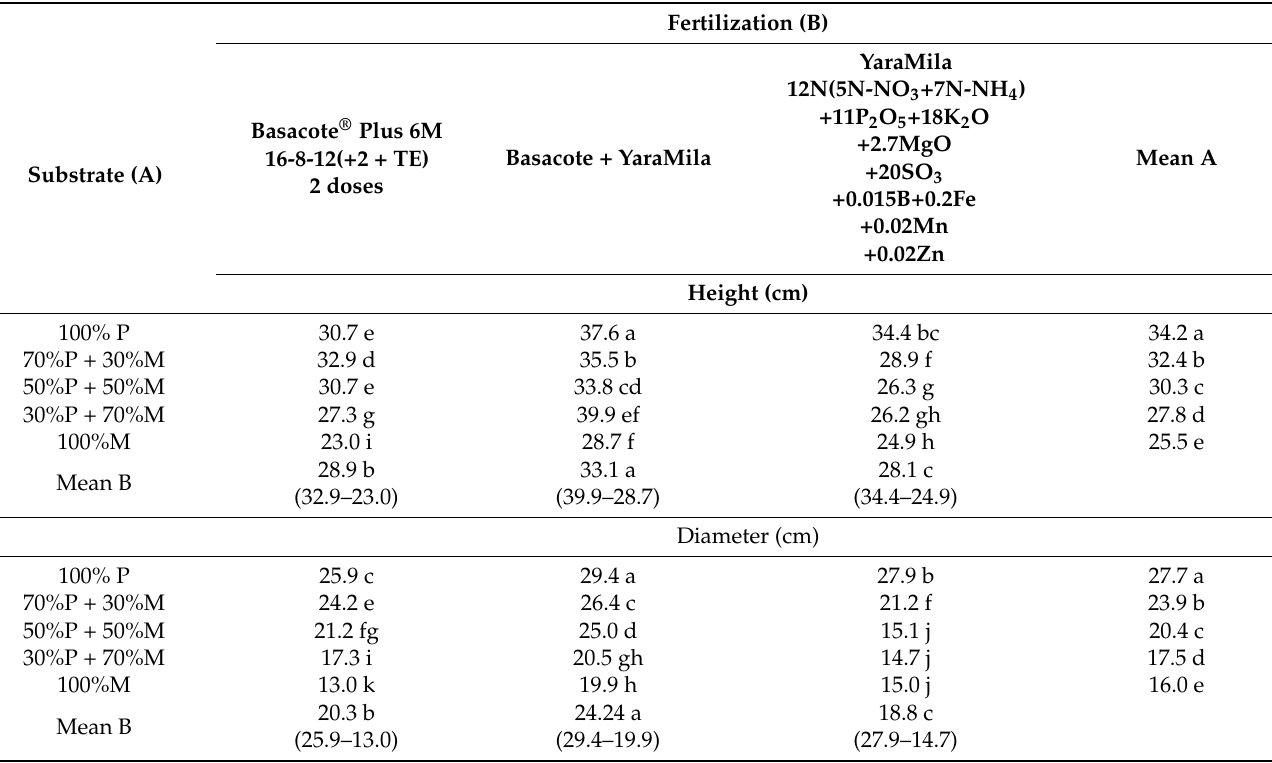
Table 1. Selected biometric features of Sedum spectabile ‘Stardust’ grown in containers with five different substrates.